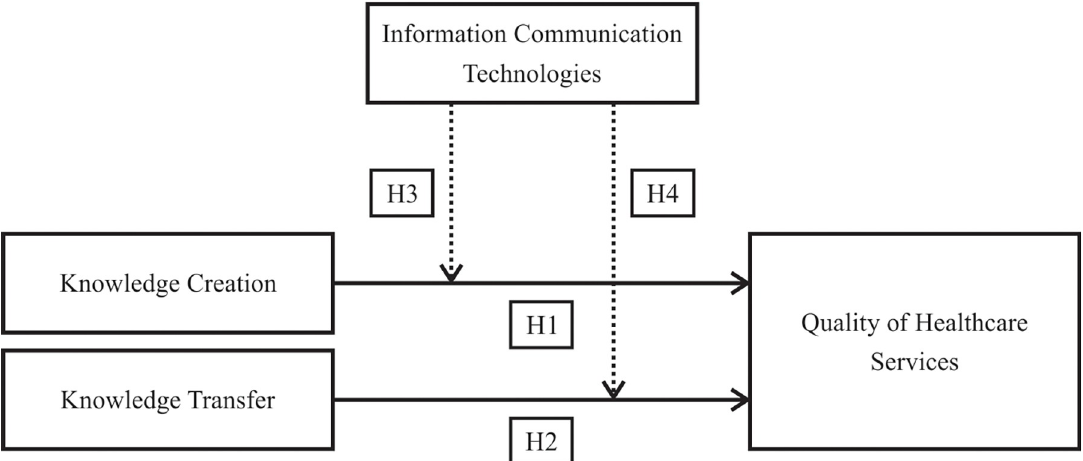
Fig 1. Conceptual model of the relationships between knowledge creation, knowledge sharing, quality of healthcare services and information communication technologies.